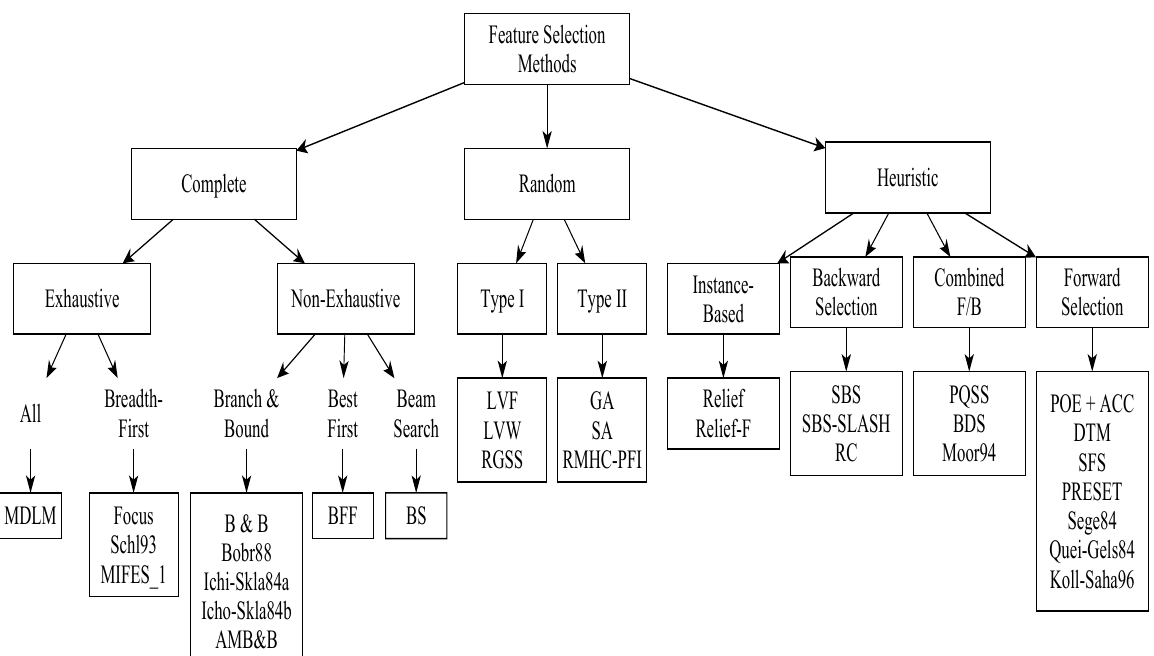
Figure 10. Categories of feature selection